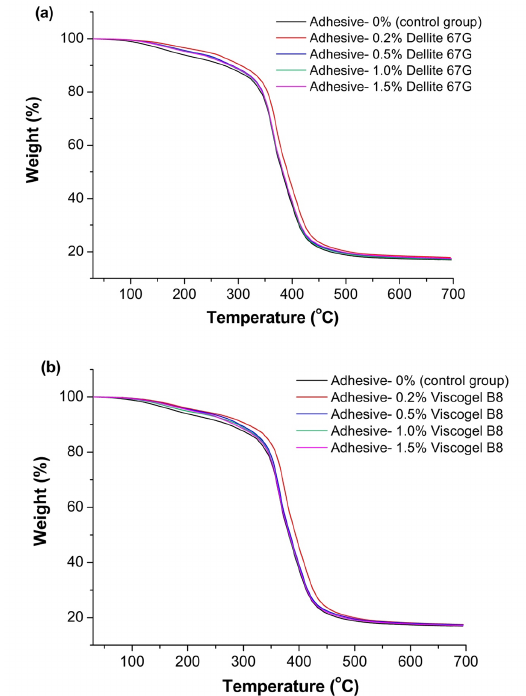
Figure 2. Curves of the thermogravimetric analysis of adhesives containing varying concentrations of the clays Dellite 67G (a) and Viscogel B8 (b)